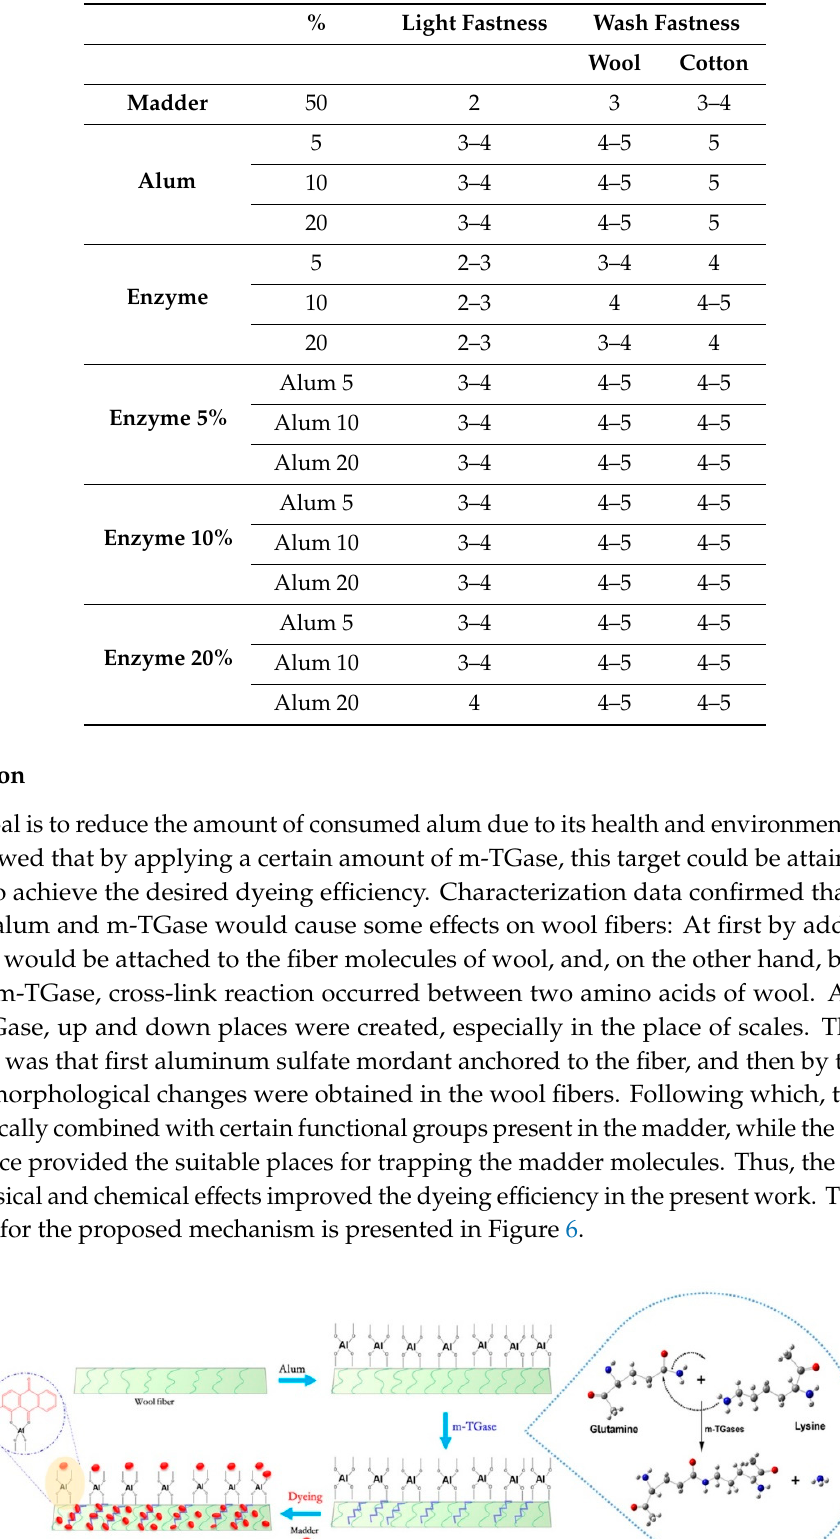
Table 3. Variation of color fastness under di ff erent treatments.